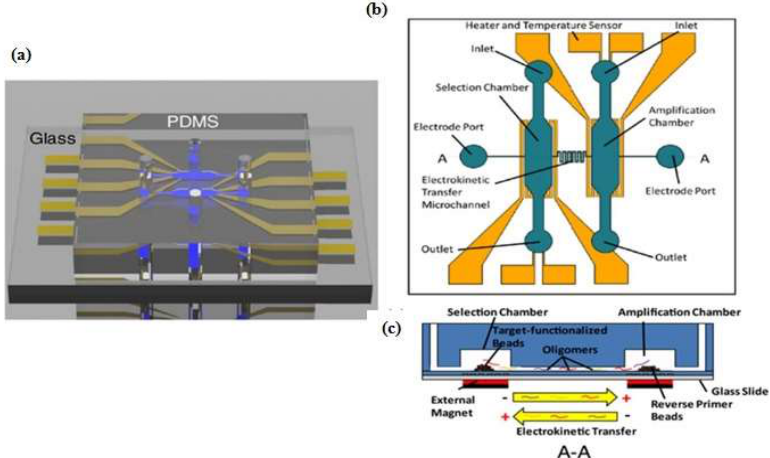
Figure 2. Schematic of microfluidic SELEX device which integrates selection and amplification steps. ( a ) Polydimethylsiloxane (PDMS) channel on glass substrate; ( b ) Top view with detailed features; ( c ) Selection and amplification microchamber connected by a single serpentine shaped microchannel. Reproduced with permission from reference [17]. Copyright 2017 Electrochemical Society.